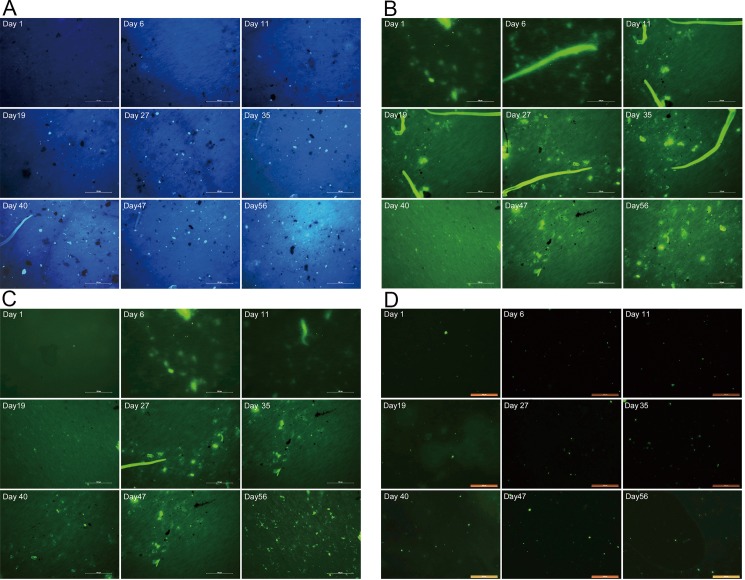
Photomicrographs of FISH stained samples.(A) DAPI stained. (B) Probe ITS targeted most of Fungi. (C) Probe Yeast targeted most of Yeast. (D) Probe EUB338 targeted most of Bacteria. Magnification = 200×, scale bar = 100 μm.